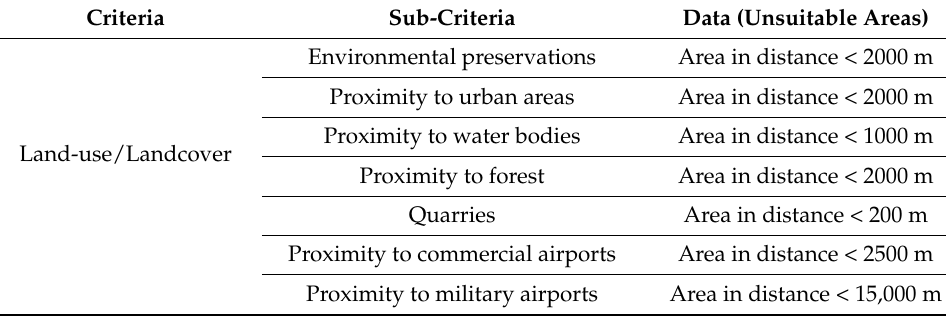
Table 1. Land-use/Landcover constraints- unsuitable areas.